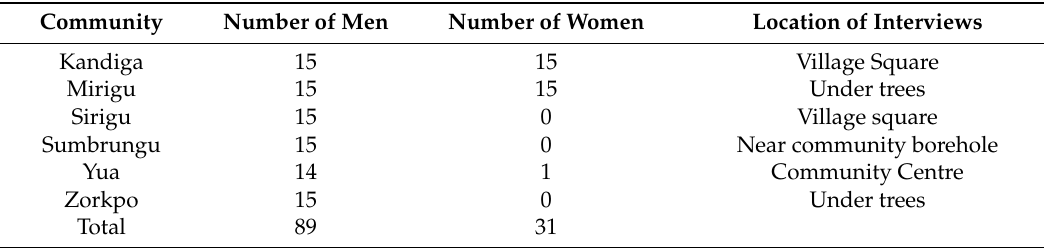
Table 2. Composition of respondents and interview